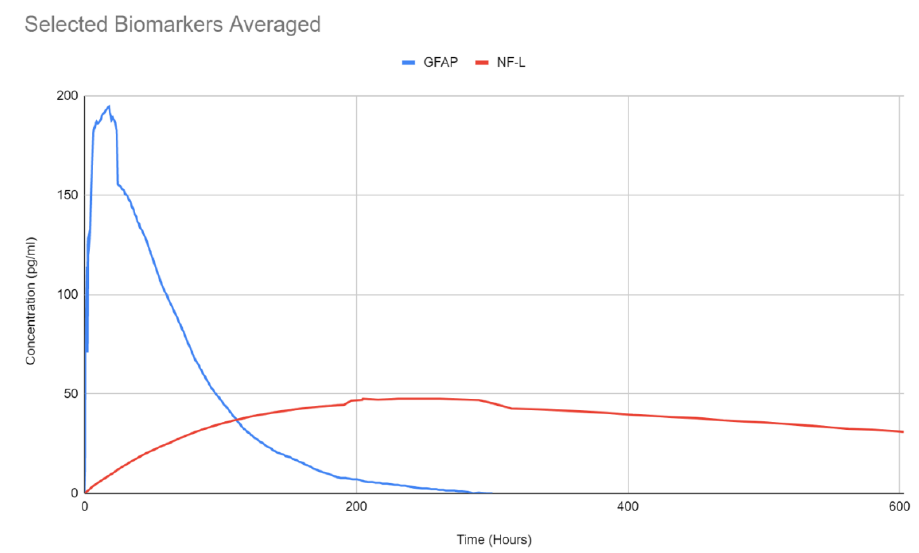
Figure 43. Average concentration data plotted for GFAP and NF-L showing NF-L stays elevated for longer duration (data from [119]).